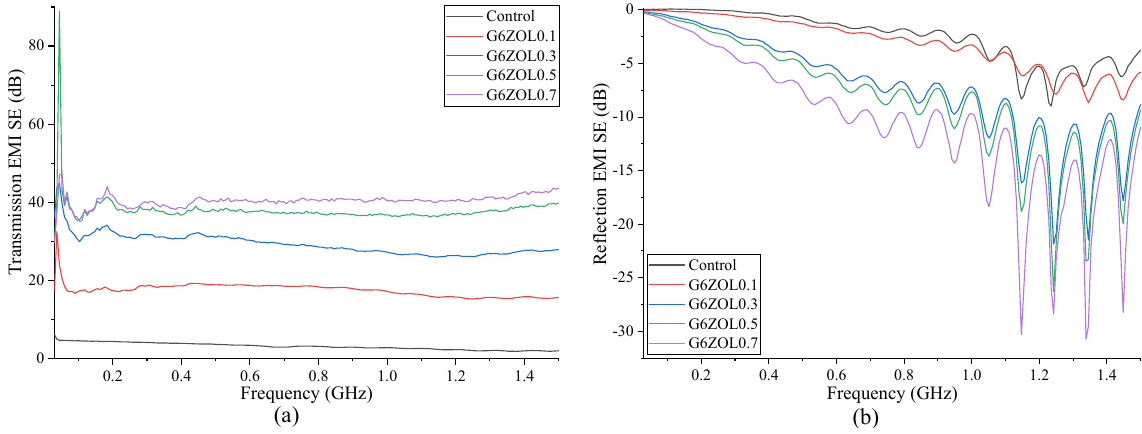
Figure 7. ( a ) Transmission EMI SE containing 6 mm CF; ( b ) reflection EMI SE containing 6 mm CF. The 12 mm CFs have shown the best EMI-shielding properties out of all the mixes. The transmission- and reflection-shielding properties of these mixes are shown in Figure